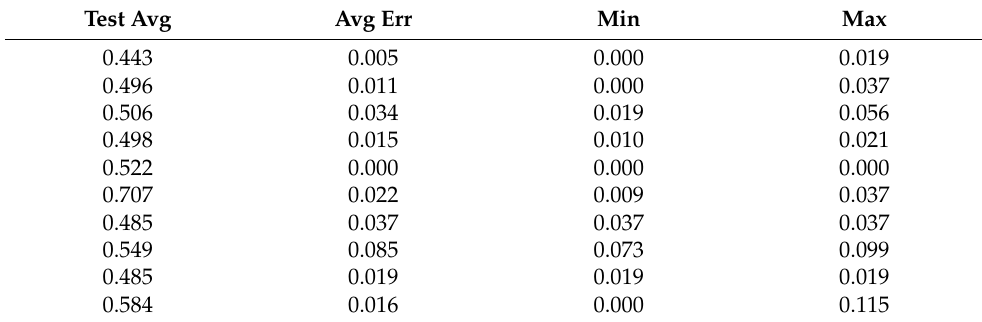
Table A190. Set 3, trials 21–30 data (single 0.5 PR value).